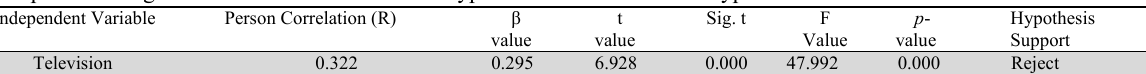
Simple linear regression results for the first sub hypothesis of the main first hypothesis Independent Variable